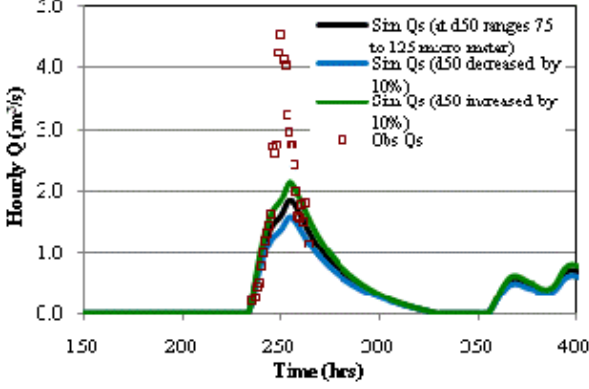
Fig. 13. Q s with different soil densities at Tateyama station. Fig. 13. Qs with different soil densities at Tateyama station.